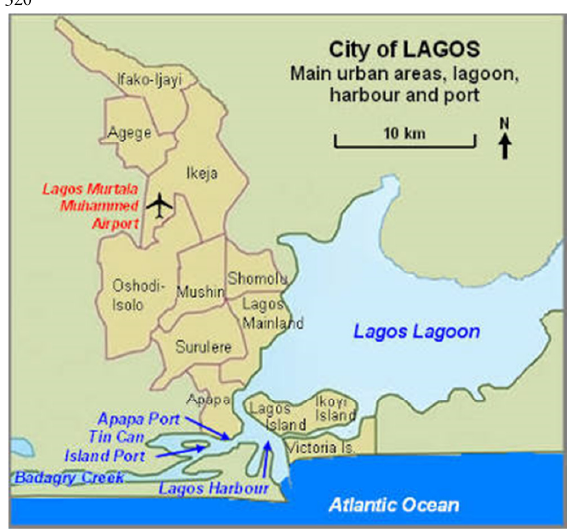
Fig. 2. Map of Lagos State showing Badagry Creek